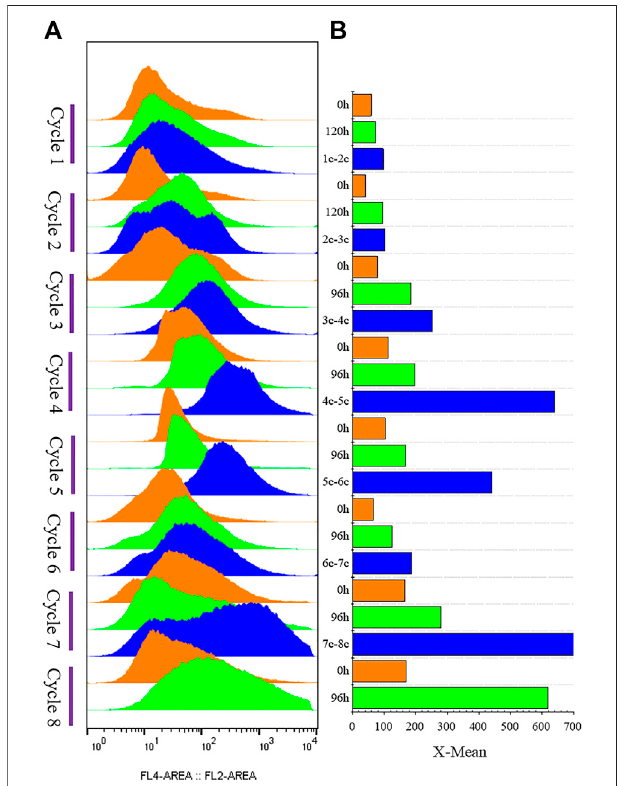
FIGURE 5 | G/Pel cell vitality after natural sedimentation for 24 h to recycle cells for semi-continuous cultivation. (A) Shows a histogram of fl ow cytometry, and the histogram migrates to the right, with increased fl uorescence and decreased cell vitality. (B) Shows the statistical data of fl uorescence detected by fl ow cytometry at different time points. Y-axis: fermentationcycles;eachcyclecontainsthreepoints.0 h(orange),theviability of remaining cells (precipitated cells); nc-n+1c (blue), the viability of cells was removed from the previous cycle; 120 or 96 h (green), the cell viability at the end of fermentation cycle. X-axis: the cell viability